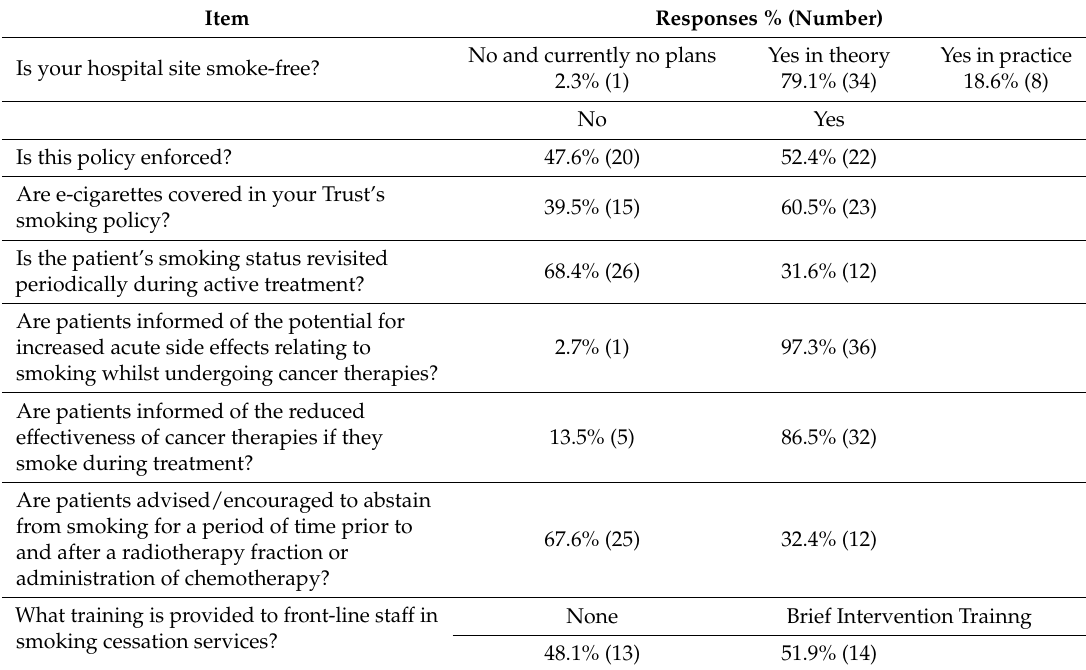
Table 1. Implementation of key National Institute Clinical Excellence (NICE)